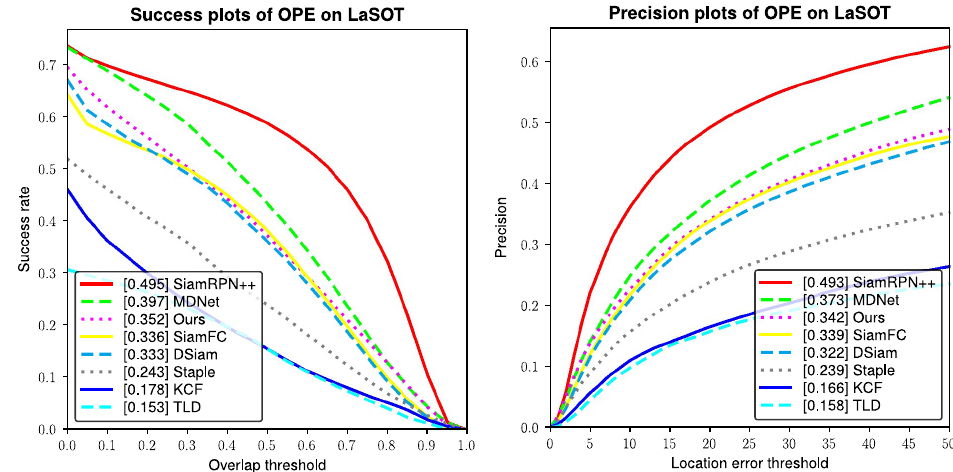
Figure 14. Success and precision plots of OPE on LaSOT